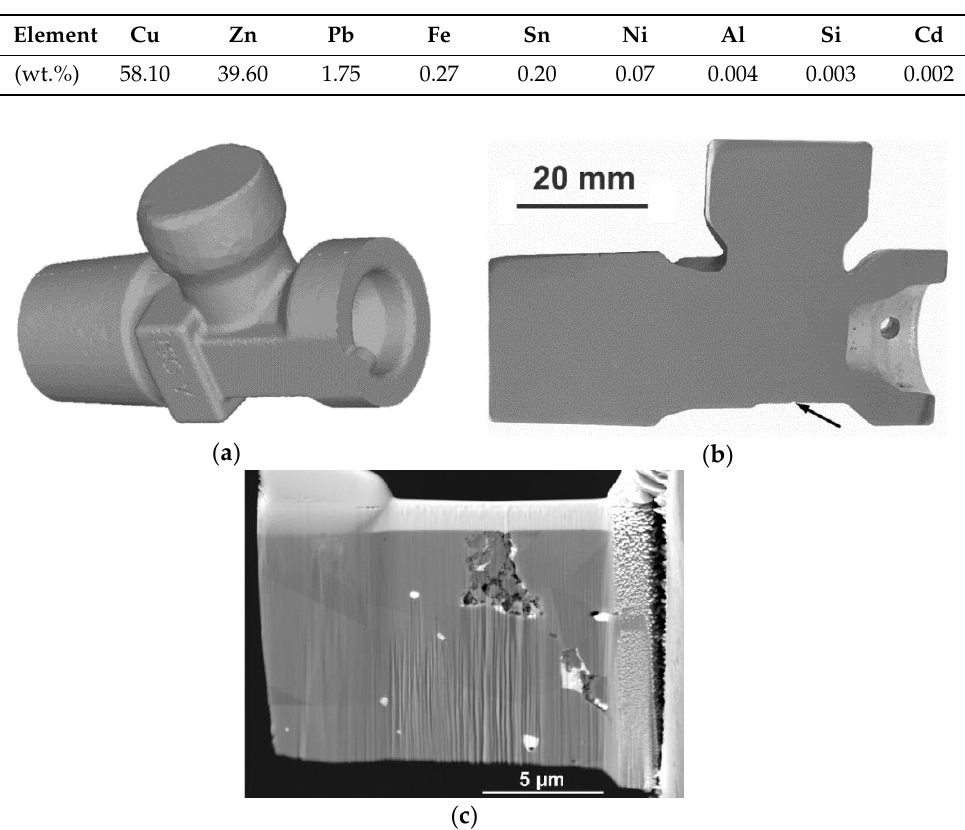
Table 1. ICP-AES analysis results of the chemical composition of the fitting.